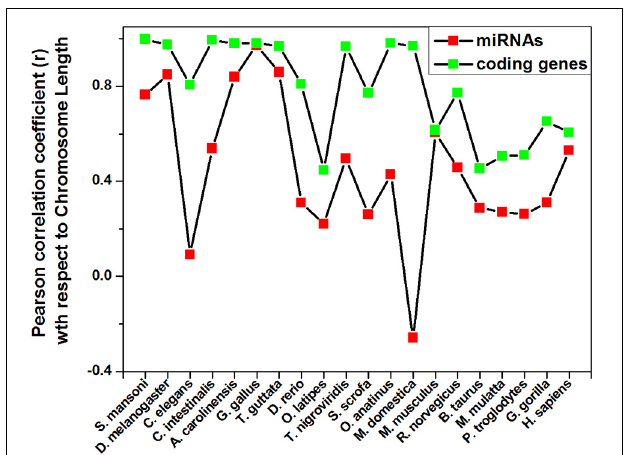
FIGURE 3 | Pattern of correlation coefficient of miRNAs and coding genes with chromosome length. The Pearson correlation coefficient of miRNAs count and coding genes count with chromosome length of a species is calculated using Microsoft Office Excel 2003 software and